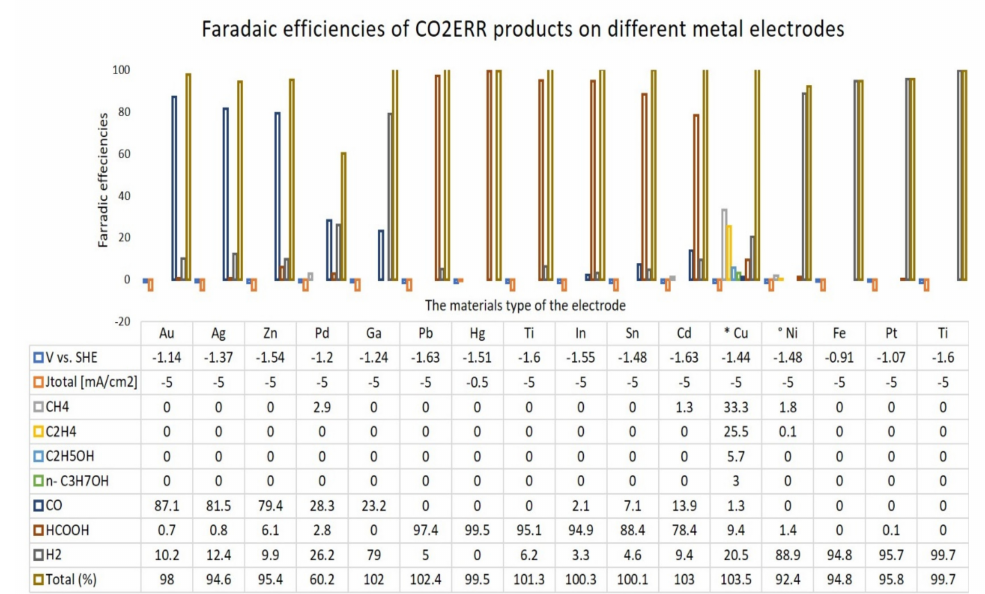
Figure 6. Faradaic efficiencies of CO 2 ERR products on different metal electrodes in 0.1 M KHCO 3 solution at 18.15 ± 0.05 ◦ C saturated with carbon dioxide. * The total value contains C 3 H 5 OH (1.4%), CH 3 CHO (1.1%), andC 2 H 5 CHO (2.3%) in addition to the tabulated substances. The total value contains C 2 H 6 (0.2%)